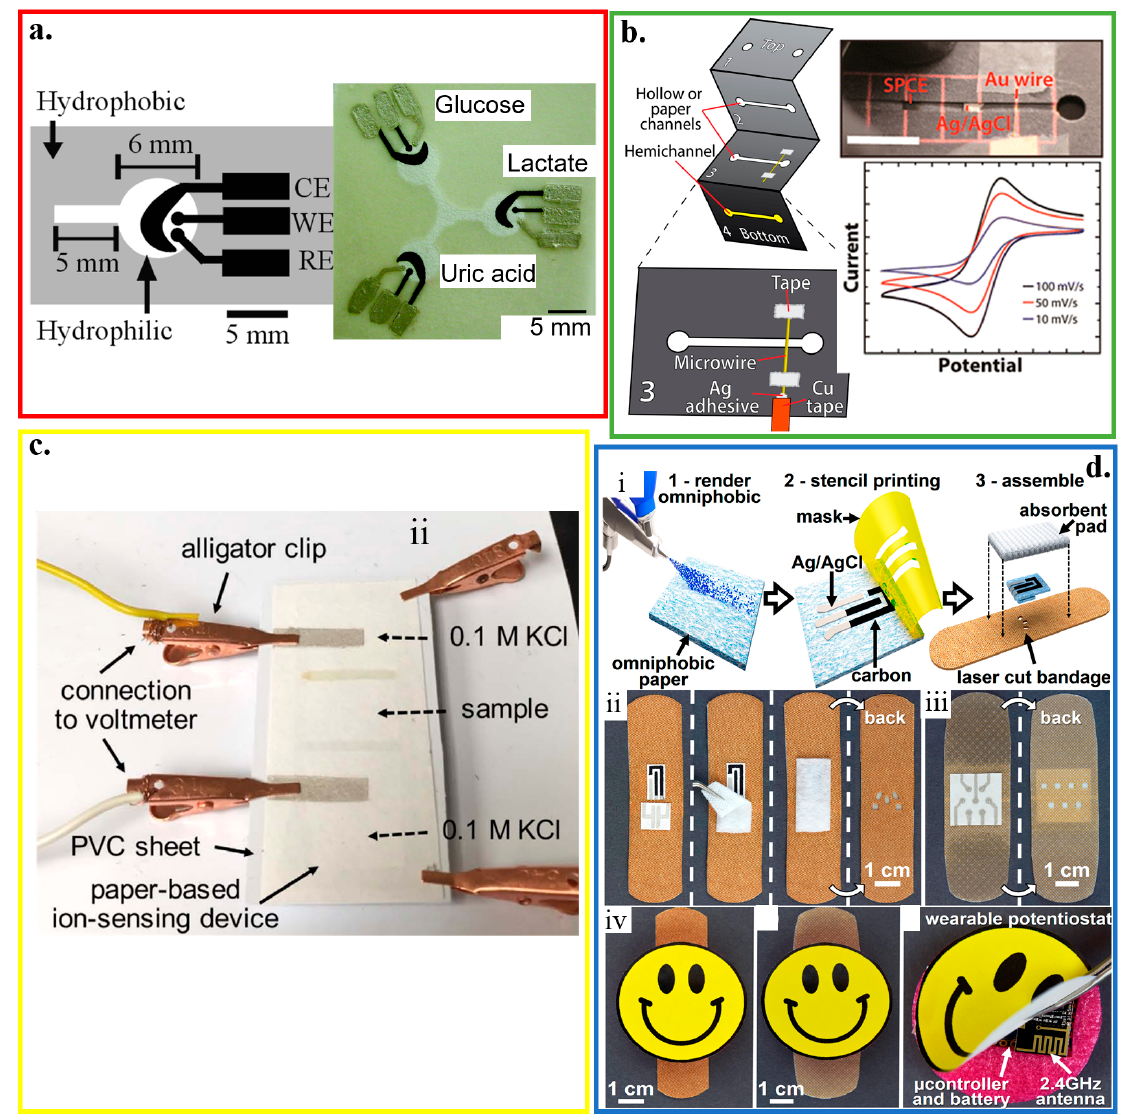
Figure 6. Paper-based electrochemical biosensors. ( a ) Design and optical image of the electrochemical Figure 6. Paper ‐ based electrochemical biosensors. ( a ) Design and optical image of the detection cell for paper-based microfluidic devices. WE / CE: working / counter electrode (carbon ink); electrochemical detection cell for paper ‐ based microfluidic devices. WE/CE: working/counter RE: reference electrode (silver / silver chloride ink); reproduced with permission from [55], Copyright electrode (carbon ink); RE: reference electrode (silver/silver chloride ink); reproduced with 2009, American Chemical Society. ( b ) Paper-based microelectrochemical devices with electrodes permission from [55], Copyright 2009, American Chemical Society. ( b ) Paper ‐ based